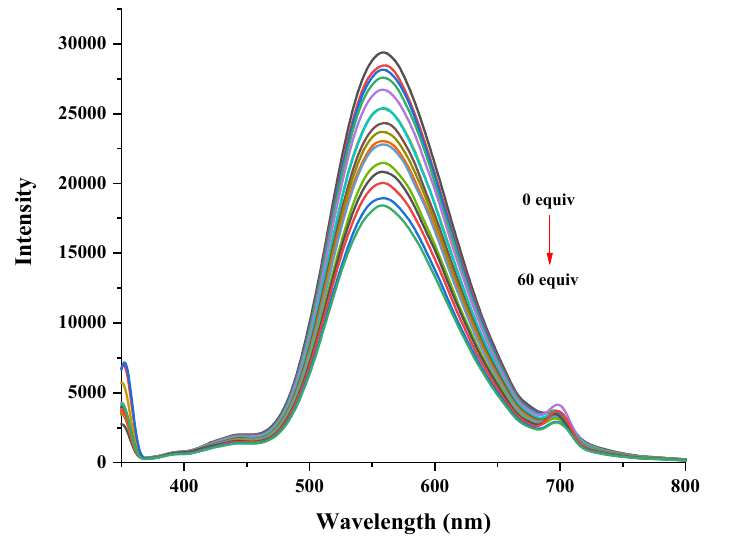
Figure 11. The fluorescence spectra in DMSO of titration between sensor R1 (5 × 10 − 5 M) and Cl − ion in the range of concentrations of 0-60 equivalents.